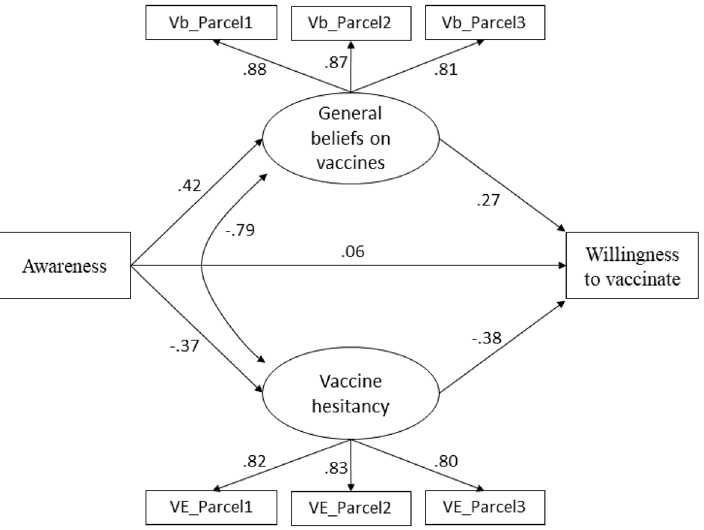
Figure 3. The role of considering oneself well-informed (awareness) on intention to vaccinate and its mediating factors. Fit indexes: χ 2 test of model fit = 92.22; df = 16 ( p < 0.001); Comparative Fit Index (CFI) = 0.991; Root Mean Square Error of Approximation (RMSEA) = 0.036 (90% CI 0.029–0.044); Standardized Root Mean squared Residual (SRMR) = 0.014). Scaling Correction Factor for MLR = 1.63. All other conventions as in Fig. 2.